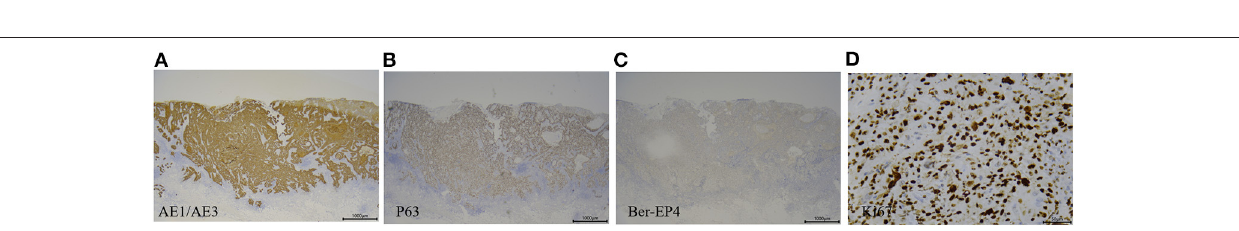
FIGURE 3 | Immunohistology of tumor specimens from patient 3. (A) Tumor cells were positive for AE1/AE3 (magnification, × 25). (B) Tumor cells were positive for P63 (magnification, × 25). (C) Tumor cells were negative for Ber-EP4 (magnification, × 25). (D) Around 40% of tumor cells were positive for Ki67 (magnification, × 400).